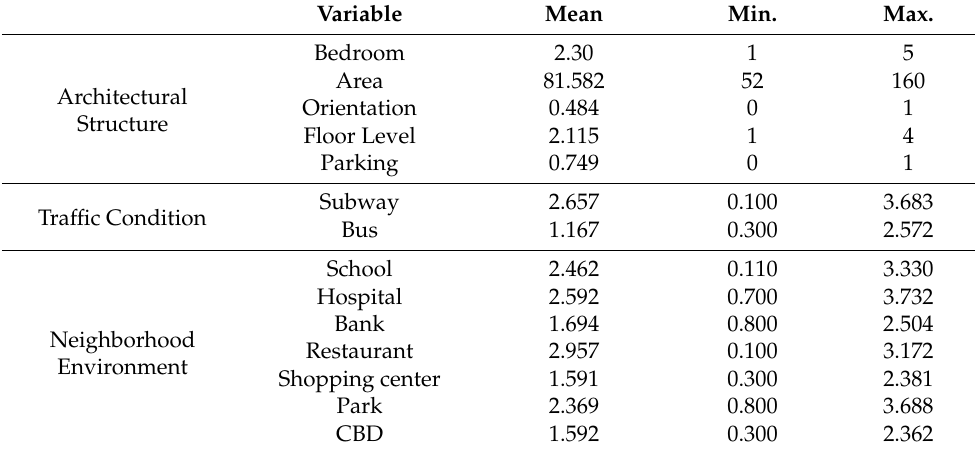
Table 5. Descriptive statistics of the